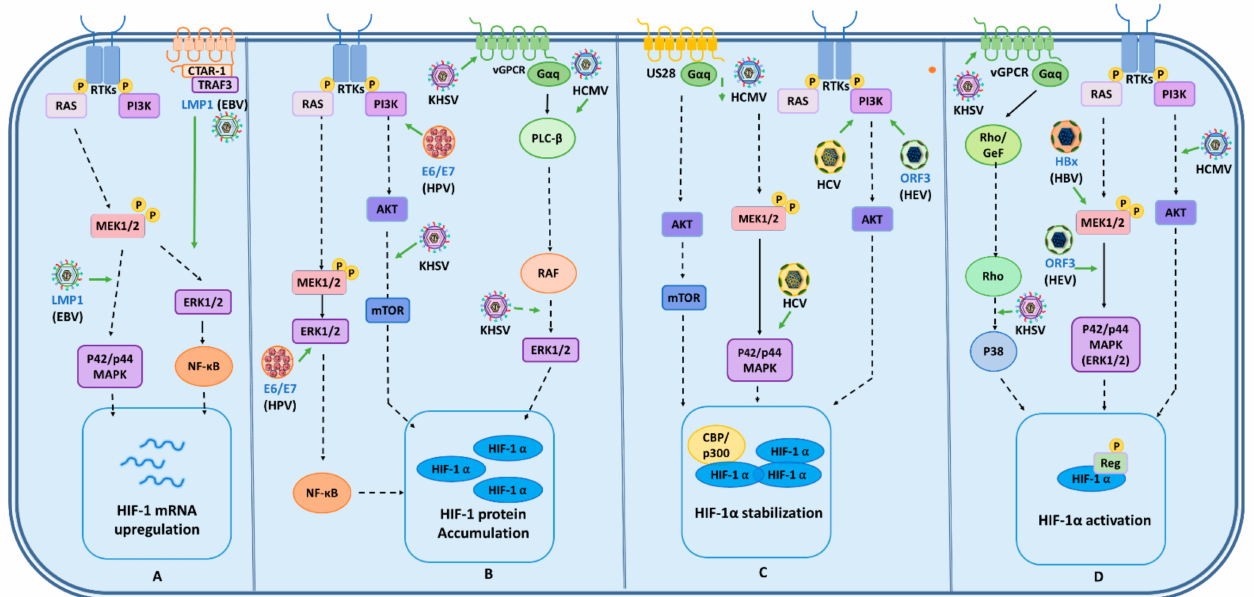
Figure 3. Viral modulation of kinase-dependent hypoxia responses. Different kinase signaling cascades lead to the activation of HIF-1 α . ( A ) The EBV latent membrane protein 1 (LMP-1), through CTAR-1, activates TRAF3, which activates the p44/p42 MAPK pathway and mediates the recruitment of ERK1/2/NF- κ B to the promoter of the HIF-1A gene resulting in the induction of HIF-1 α transcription. ( B ) KHSV, through vGPCR is capable of inducing ERK1/2 and AKT signaling pathways, increasing HIF-1 α . HPV type 16 oncoproteins E6 and E7 induce HIF-1 α protein accumulation by activating the ERK1/2 and PI3K/AKT pathways. ( C ) Hepatitis viruses have also been reported to have the capacity to activate kinases to upregulate HIF-1 α . For instance, to promote HIF-1 α stabilization, HCV and the ORF3 protein of HEV can activate the PI3K/AKT pathway, while the ORF3 protein of HEV also induces ERK1/2-dependent phosphorylation of CBP/p300 to transactivate HIF-1 α . Moreover, HCMV induces the upregulation of HIF-1 α stabilization through the viral chemokine receptor US28, by modulating a G α q calcium/calmodulin-dependent protein kinase II (CaMKII). ( D ) To promote HIF-1 α , HBV virus protein X (HBx) induces the nuclear translocation and activation of HIF-1 α , by activating the MFK1/2 ERK pathway. On the other hand, HCMV may activate HIF-1 α through the PI3K/AKT/mTOR pathway. Similarly, KHSV has been shown to upregulate vGPCR, and induce the paracrine activation of the alpha subunit of a Gq protein receptor, which promotes p38-dependent phosphorylation of the regulatory domain of HIF-1 α and its concomitant upregulation. EBV: Epstein–Barr virus; KHSV: Kaposi’s Sarcoma-associated herpesvirus; HPV: Human papillomavirus; HCV: Hepatitis C virus; HEV: Hepatitis E virus; HBV: Hepatitis B virus; HCMV: Human